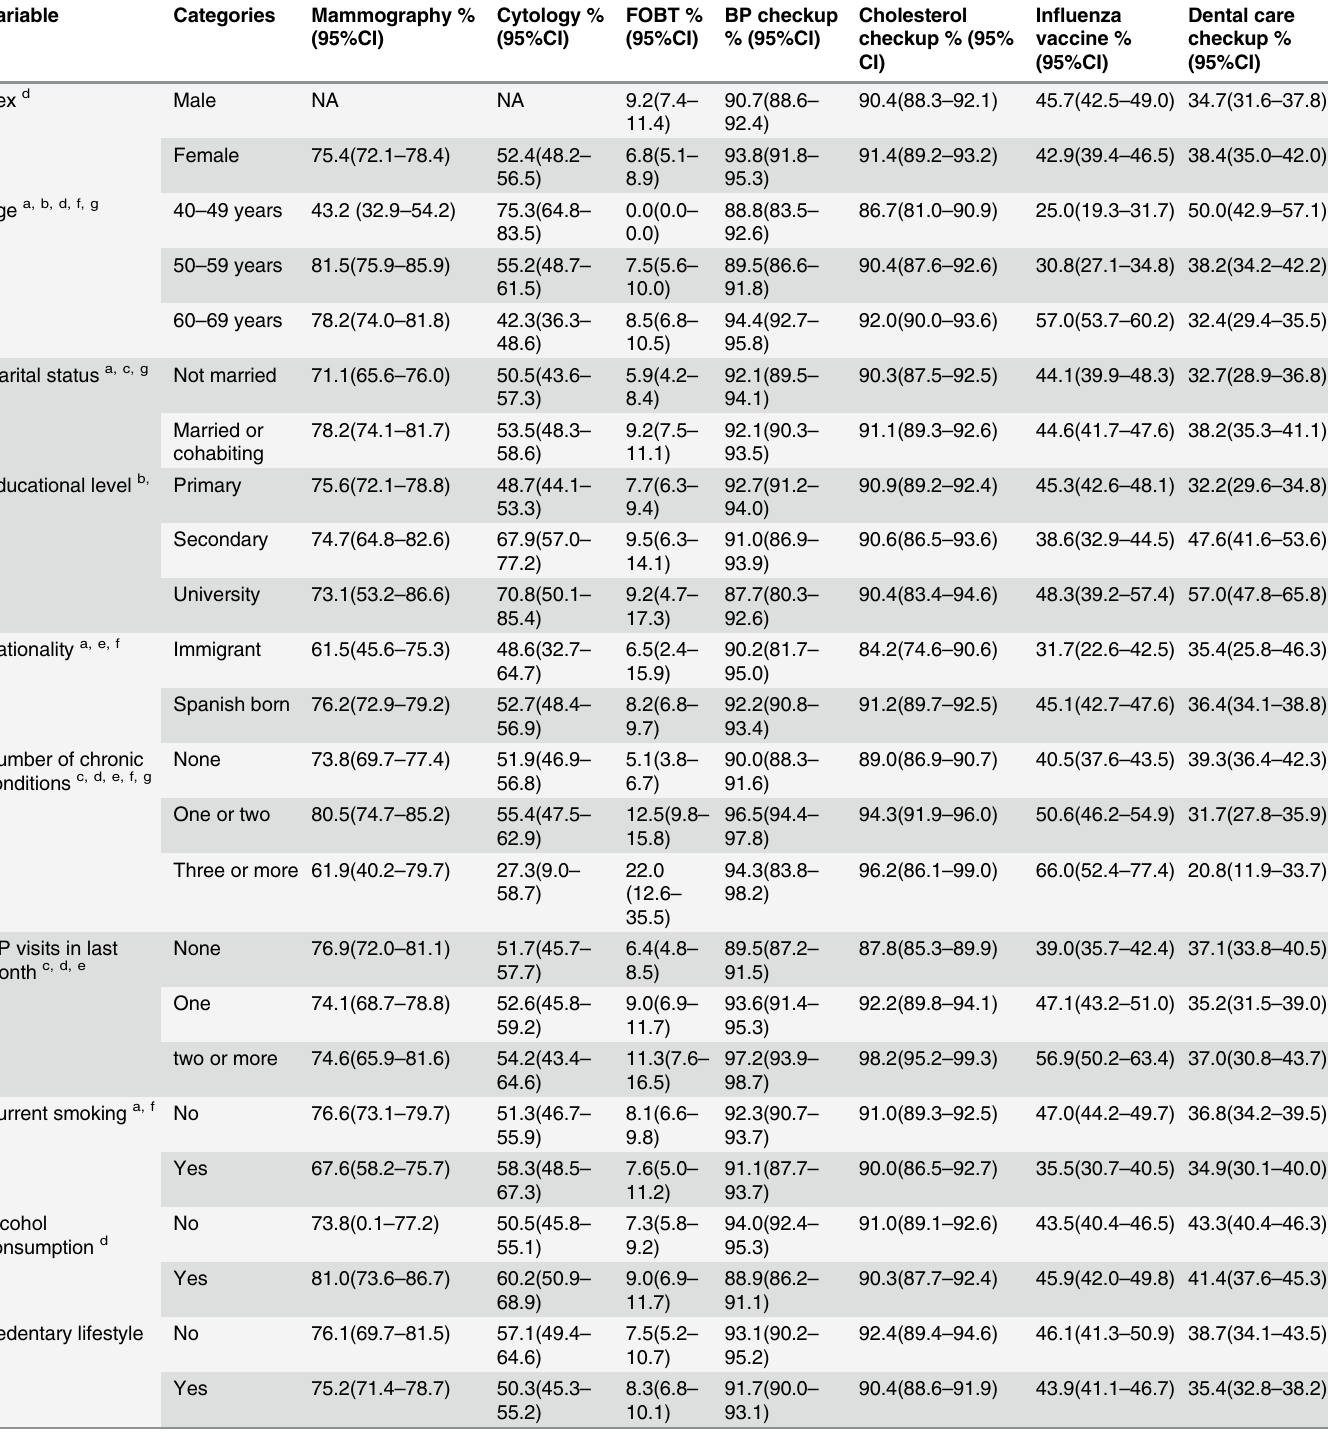
Table 2. Adherence to clinical preventive recommendations among diabetes patients according to study